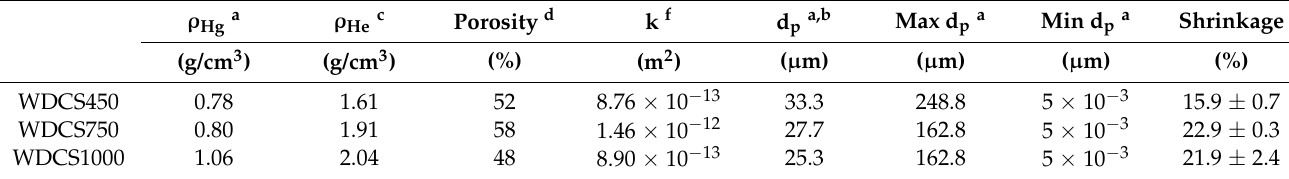
Table 1. Densities, porosity, permeability, predominant, maximum and minimum pore sizes and linear shrinkage of the WDCSs.